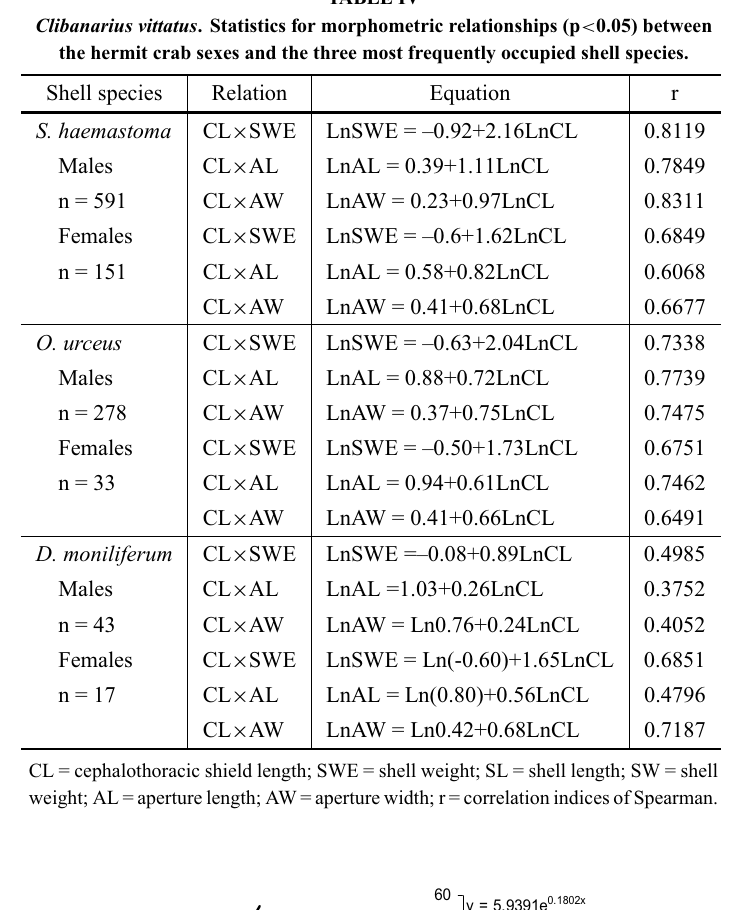
y = 0.6355e 0.3534x R 2 = 0.706